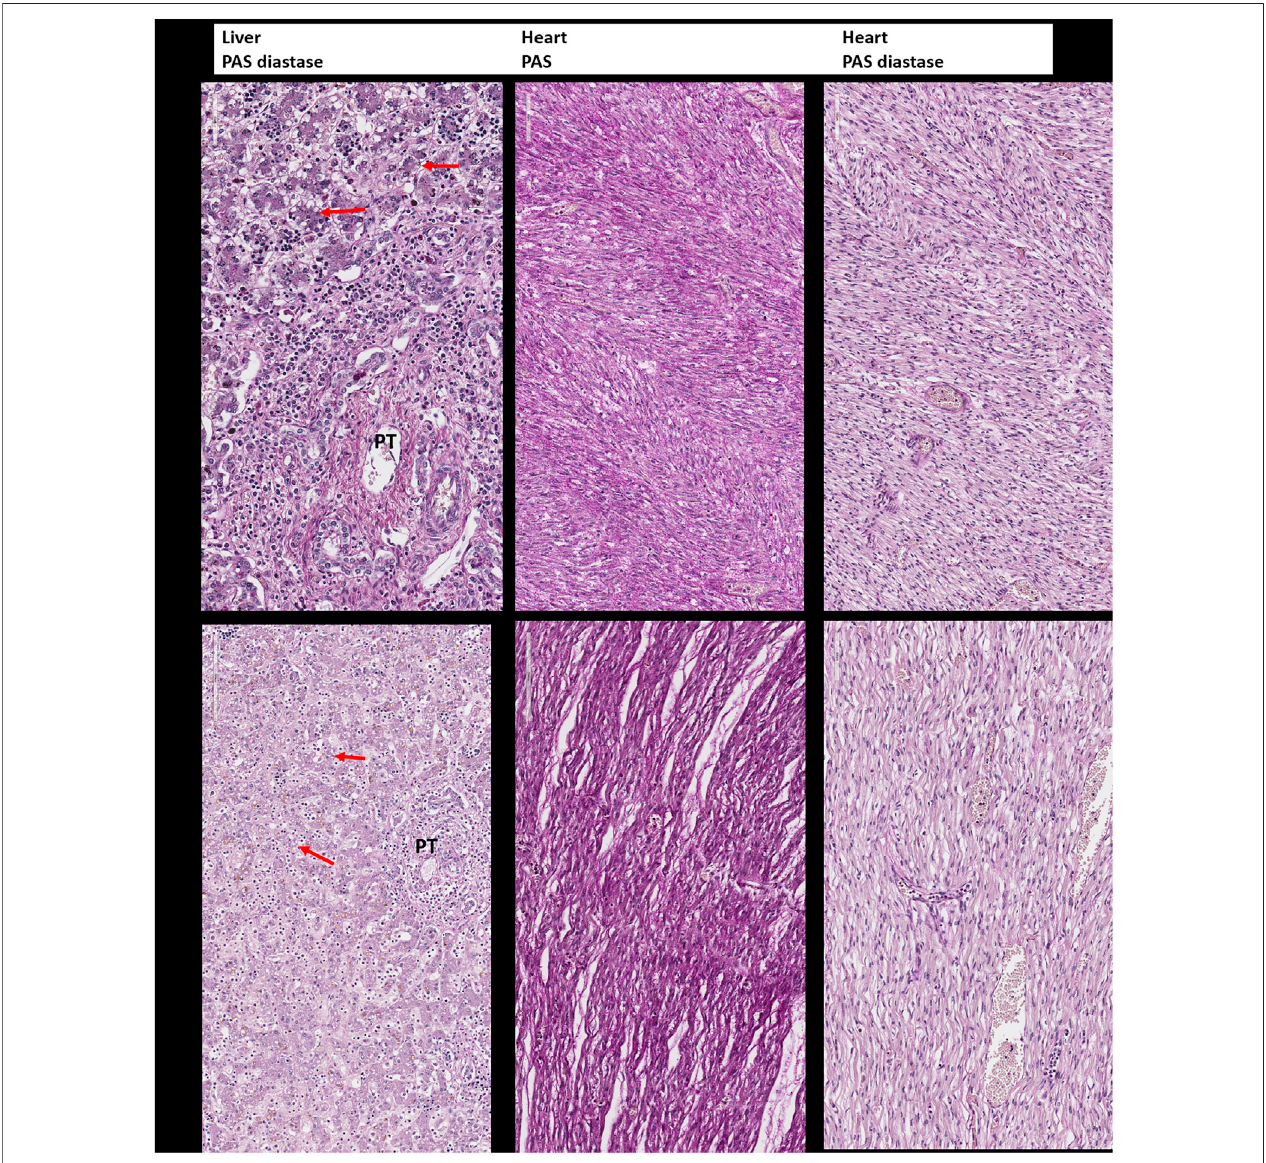
FIGURE 2 | Periodic Acid – Schiff (PAS) and Periodic Acid – Schiff – diastase (PAS-D, PAS diastase) staining for the detection of glycogen. Upper panel: Liver and heart tissue of the fi rst child: no evidence of glycogen storage and diffuse small vacuoles of steatosis in the hepatocytes (arrow). PT: portal tract. Lower panel: Liver and heart tissue of the second child with the same fi ndings as in the